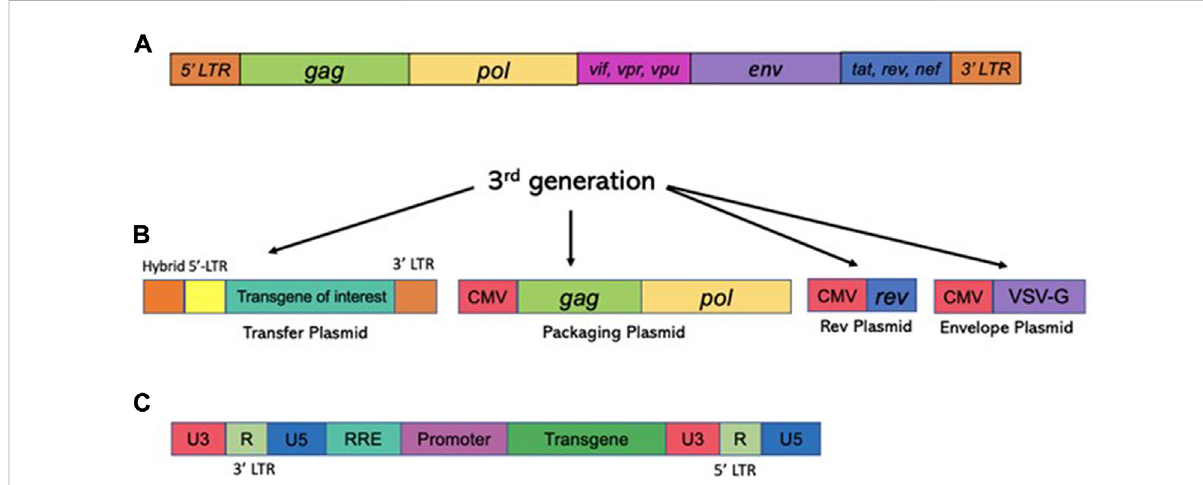
FIGURE 4 Structure of the HIV-1 based vectors (lentiviral vectors) and the packaging cassettes. The third generation of the packaging cassette is shown. Upper panel (A) The wild type HIV-1 genome is shown. The genome contains four accessory proteins, Vpu, Vpr, Vif, and Nef and the regulatory proteins,tatandrev.RREstands forrevresponseelement.The 3 rd generationofthepackaging vector cassetteisshown. (lower panel) (B) Expression of lentiviral vector is driven from the CMV promoter; PolyA signal (pA) is shown. The 3rd generation excluded all four accessory proteins, Vpu, Vpr, Vif, and Nef, but included regulatory proteins, tat and rev. The vector packaging cassette contains RRE and pA signals. CMV, cytomegalovirus; RRE, Rev response element. Here, the transfer cassette depicted as RNA; 5 ′ LTR and 3 ′ LTR are listed. (C) Schematic image of viral DNA following the completion of RT process. U3 ′ region bears the promoter which drives an expression of the transcript. Self-inactivated vectors harbor deletion in U3 region, such that the full transcript expression is not supported. The internal promoter, painted in lilac color drives an expression of a transgene- of-interest (painted in